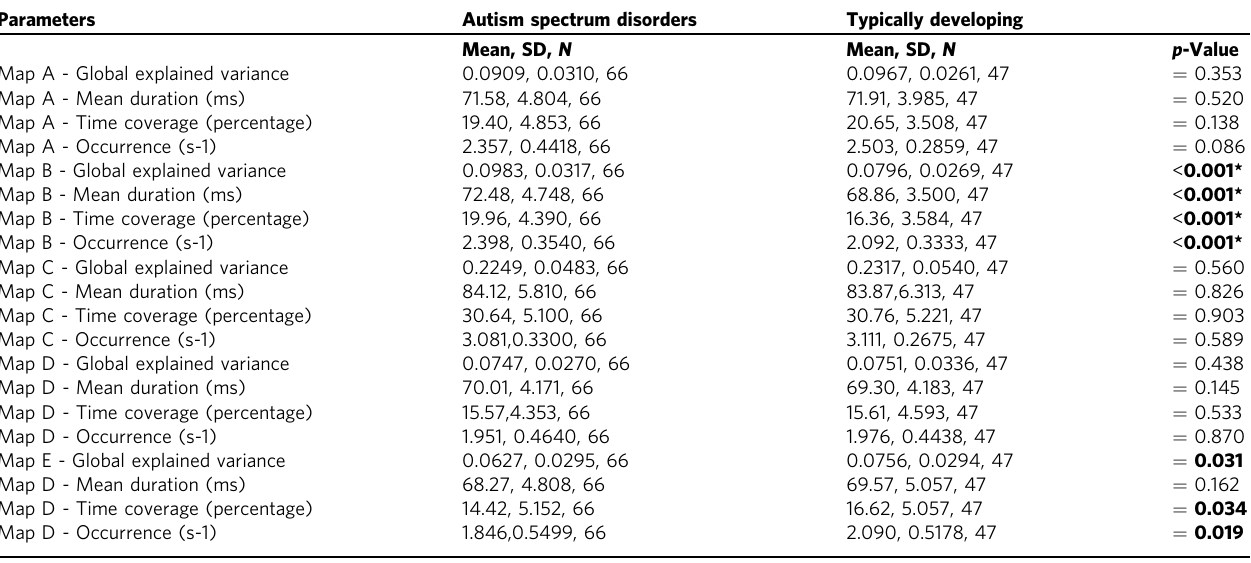
Table 1 Temporal parameters for the fi ve maps of autism spectrum disorders (ASD) group and typically developing (TD)